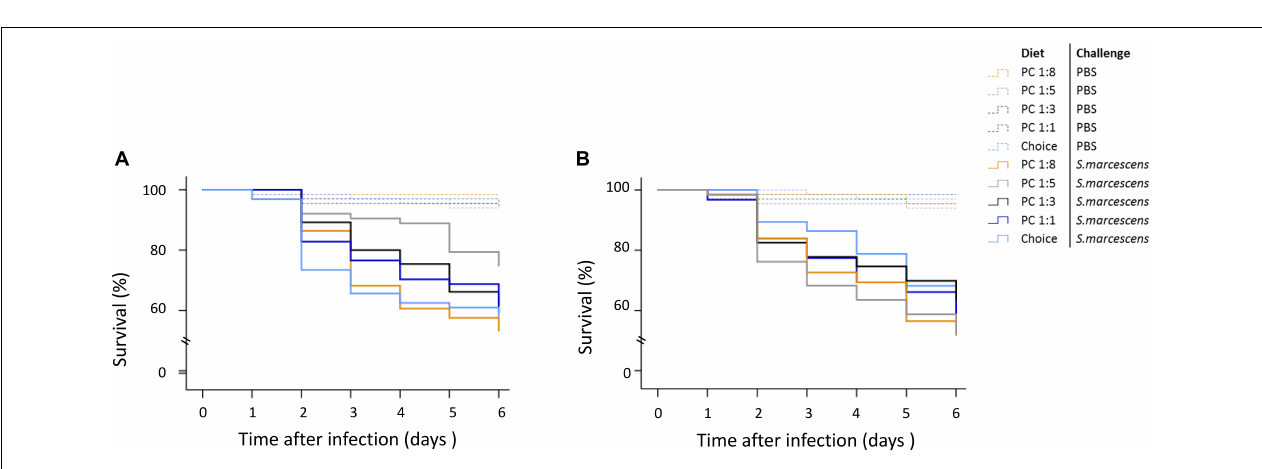
FIGURE 3 | Effect of maternal diet on offspring survival during the first 6 days post septic infection. Mothers were fed one of five diets varying in the protein-to-carbohydrate ratio (PC ratio) whereas fathers were fed a choice diet. Their sons (A) and daughters (B) were injected with either PBS or Serratia marcescens at adult stage. Lines indicates Kaplan–Meier survival curves [dash lines (non-infected flies), continuous lines (infected flies)]. Colours indicate maternal diet treatments [orange (PC 1:1), light grey (choice diet), dark grey (PC 1:3), dark blue (PC 1:5) and light blue (PC 1:8)]. Significant differences between survival curves were determined by Cox regression analysis at P <